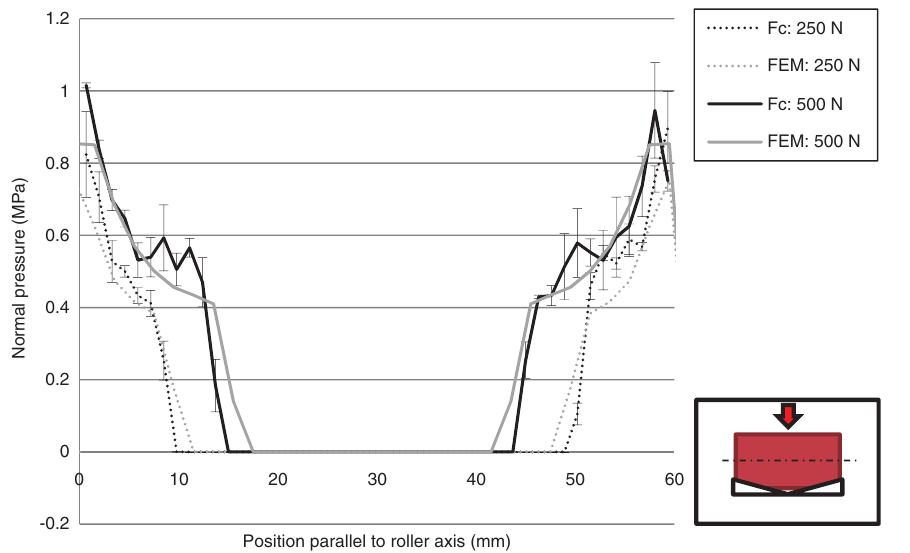
Figure 24 Normal pressure of the compaction roller in lateral direction parallel to roller axis on the concave